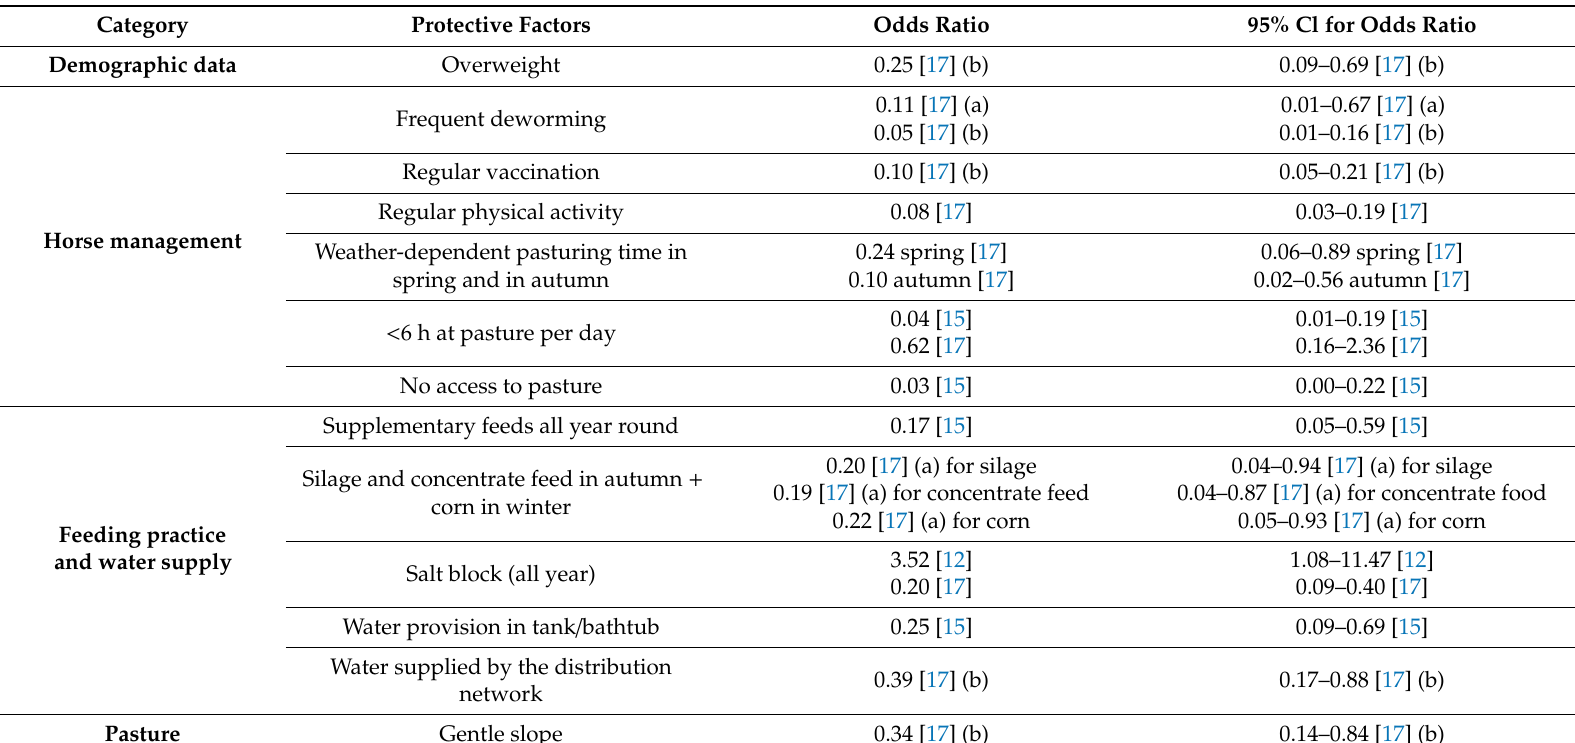
Table 3. Protective factors identified in former epidemiological studies